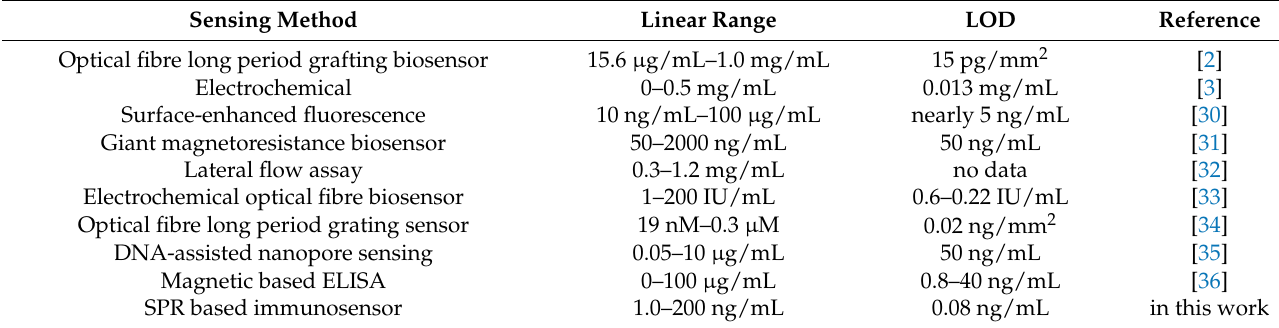
Table 1. The comparison results of the other immunosensing platforms by using anti-hIgM antibodies for IgM detection according to sensing methods, linear ranges and the limit of detection (LOD) values. Sensing Method Linear Range LOD